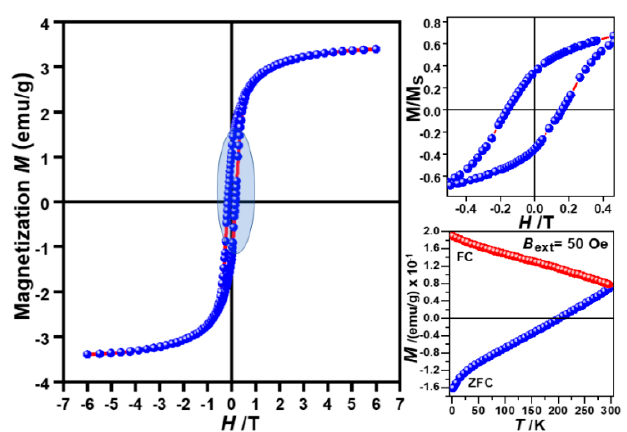
Figure 2. Field-dependent magnetization hysteresis curve of NL004 at 4 K. The blue-shaded area is shown for clarity reasons at the right part of the figure where the y -axis is given in the form of M/Ms with M s = 3.15 emu/gr (saturation value of magnetization for NL004). At the right part is also shown the ZFC-FC temperature dependence of the DC susceptibility data of NL004 at external magnetic field of 50 Oe.